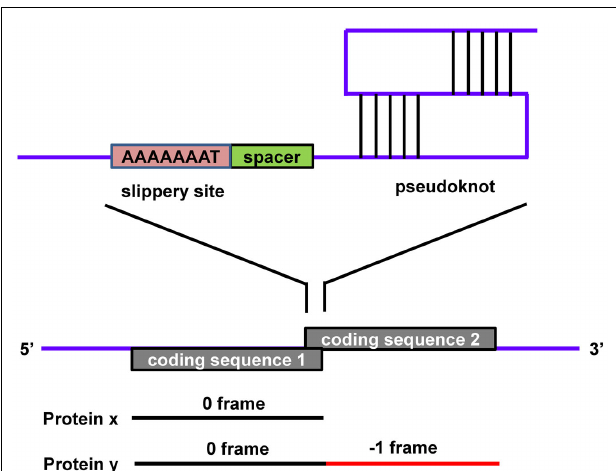
FIGURE 3 |A typical − 1 ribosomal frameshift signal contains a slippery site, a spacer, and a pseudoknot. Protein x is produced in the 0 frame from CDS 1 while a − 1 frameshift bypasses the stop codon, resulting in the fusion of CDS 1 and CDS 2, which produces a longer protein, y.